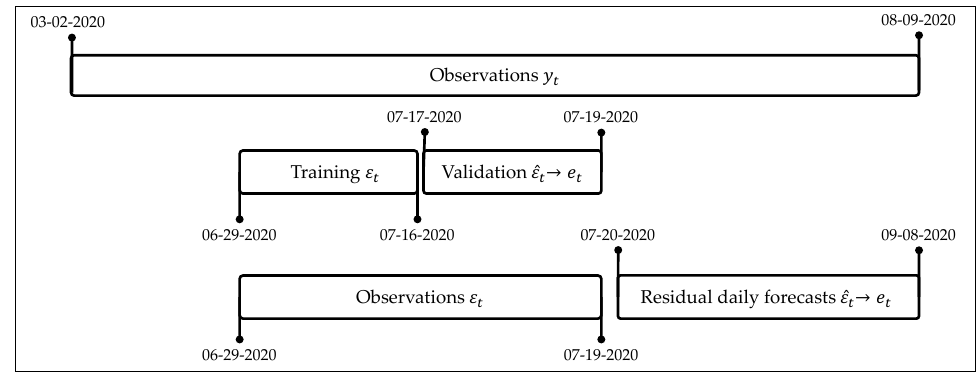
Figure 3. Split of the observations in training and validation set by adjusting